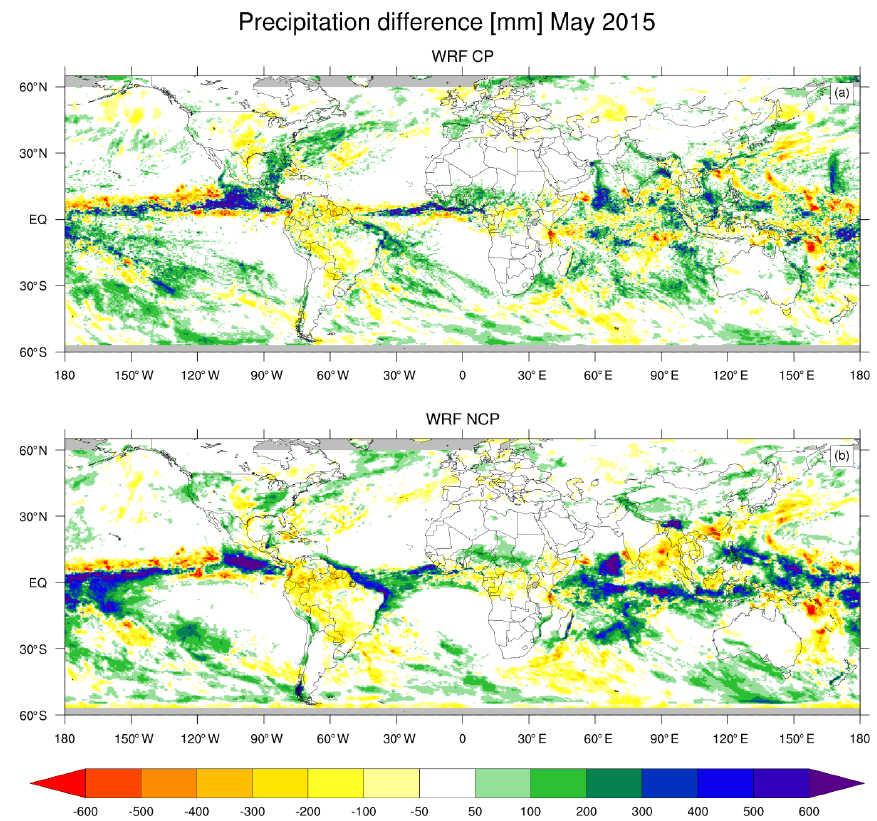
Figure 7. Precipitation difference (mm) between CP and GPM (a) and difference between NCP and GPM (b) during May 2015.